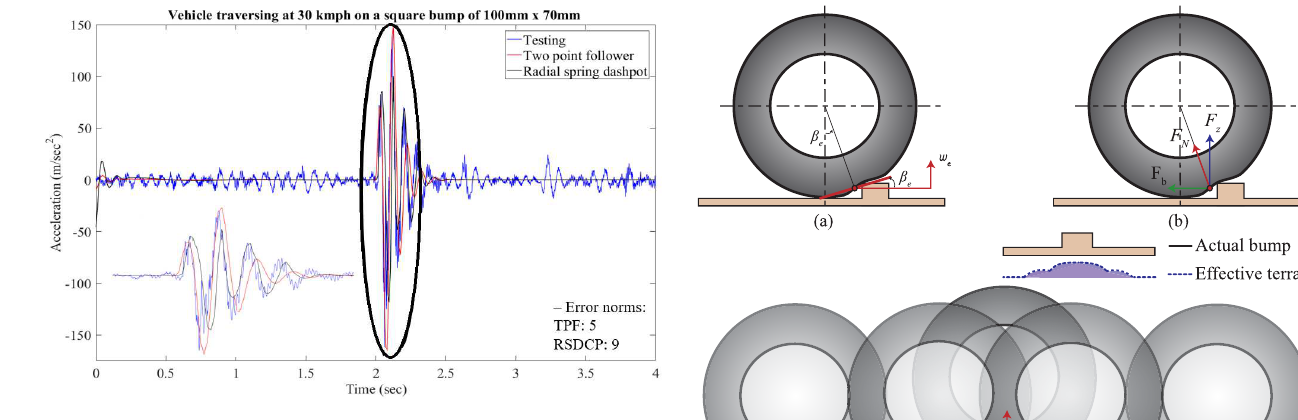
Fig. 7. Two point follower and radial spring-dashpot model responses against the measured axle responses. The zoomed por- tion shows that the two-point follower fits better to the test measurements as compared to the latter. The root mean square fitting error norms are also reported in the plot.